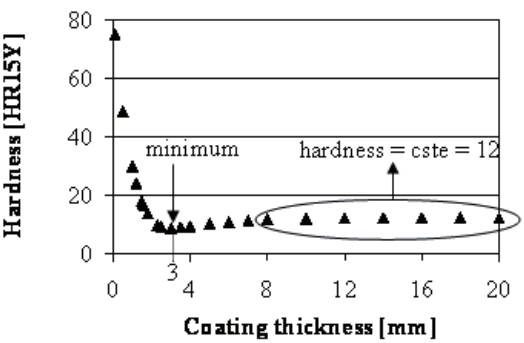
Fig. 1. Micrograph of a typical abradable coating structure; left: surface view – right: cut view.